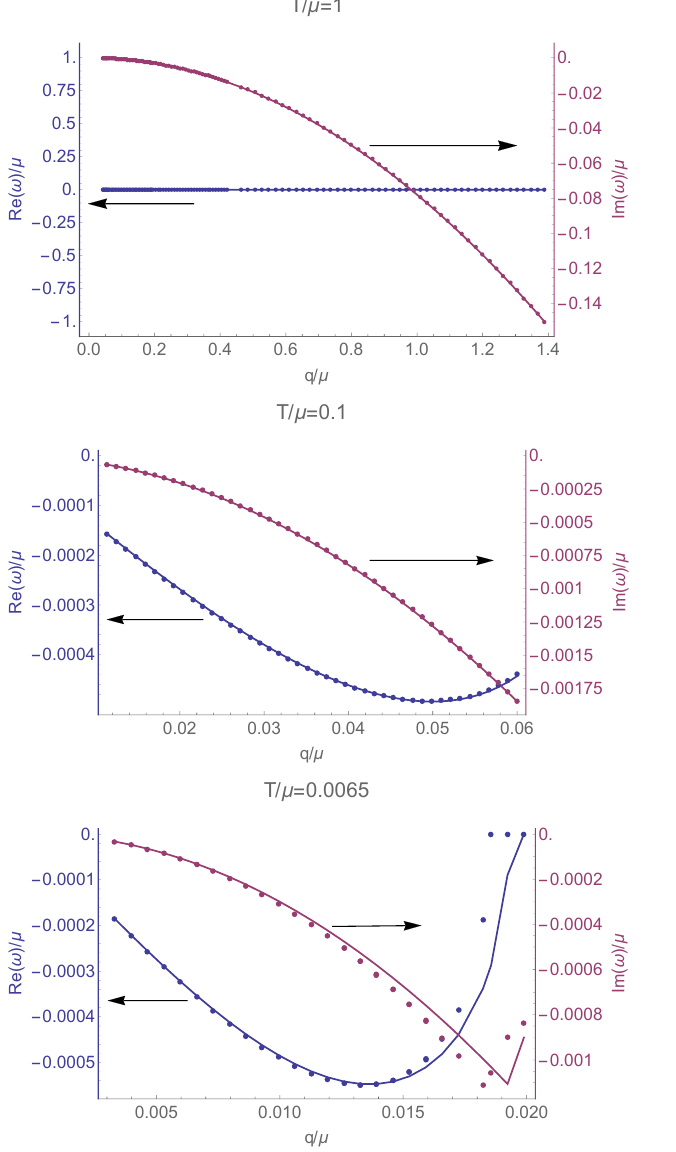
Figure 4 . Comparison of the exact location (dots, numerics) and hydrodynamic approxima- tion (6.1) (solid lines) of the real (blue, left axis) and imaginary (magenta, right axis) part of the transverse hydrodynamic QNM at T=(cid:22) = 1 (top), T=(cid:22) = 0 : 1 (center) and T=(cid:22) = 0 : 0065 (bot- tom) vs q=(cid:22) . In the top panel, the modes are purely imaginary, but would acquire a real part at smaller q (not